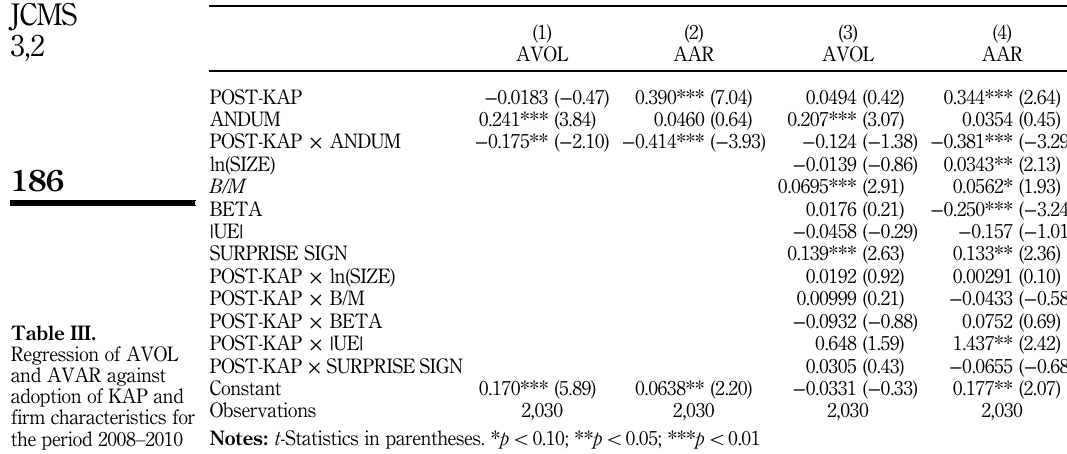
Table III. Regression of AVOL and AVAR against adoption of KAP and firm characteristics for the period 2008 –